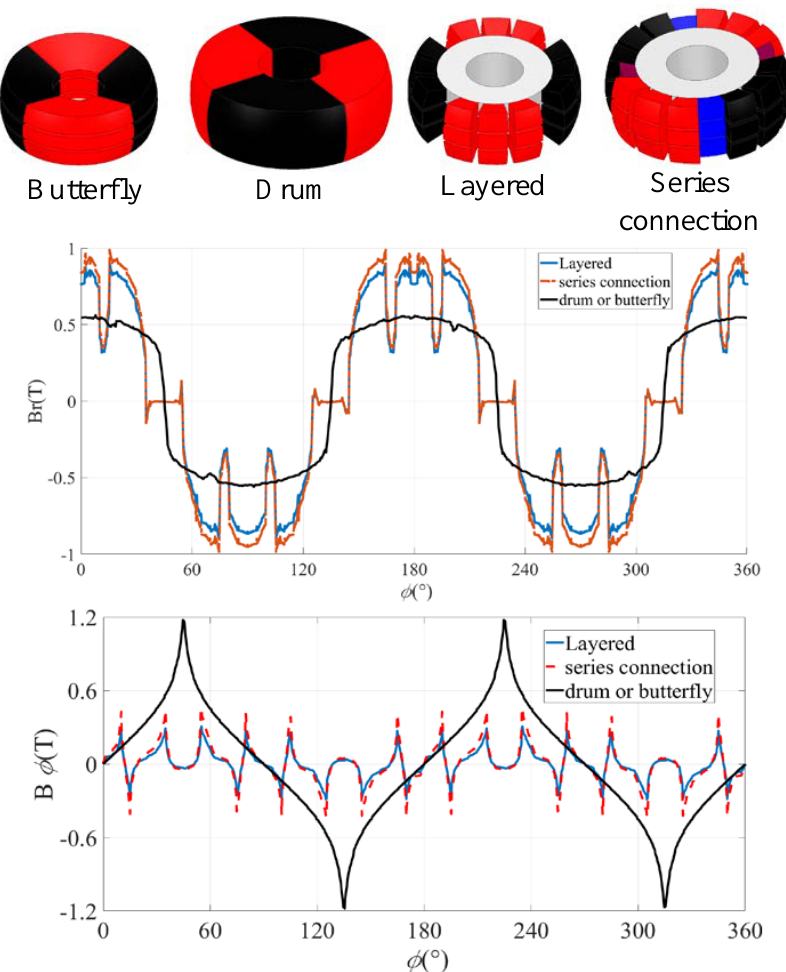
Figure 12. Comparison of radial magnetic density of four types of rotor.